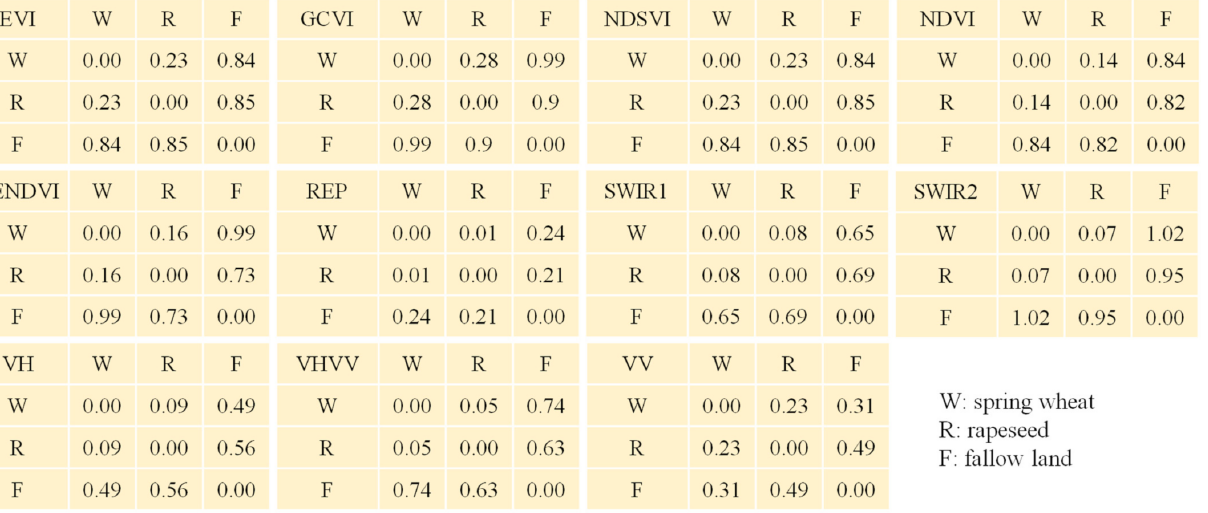
Figure 7. The M value between spring wheat, rapeseed, and fallow land for 12 features (W, R, and F represent spring wheat, rapeseed, and fallow land,